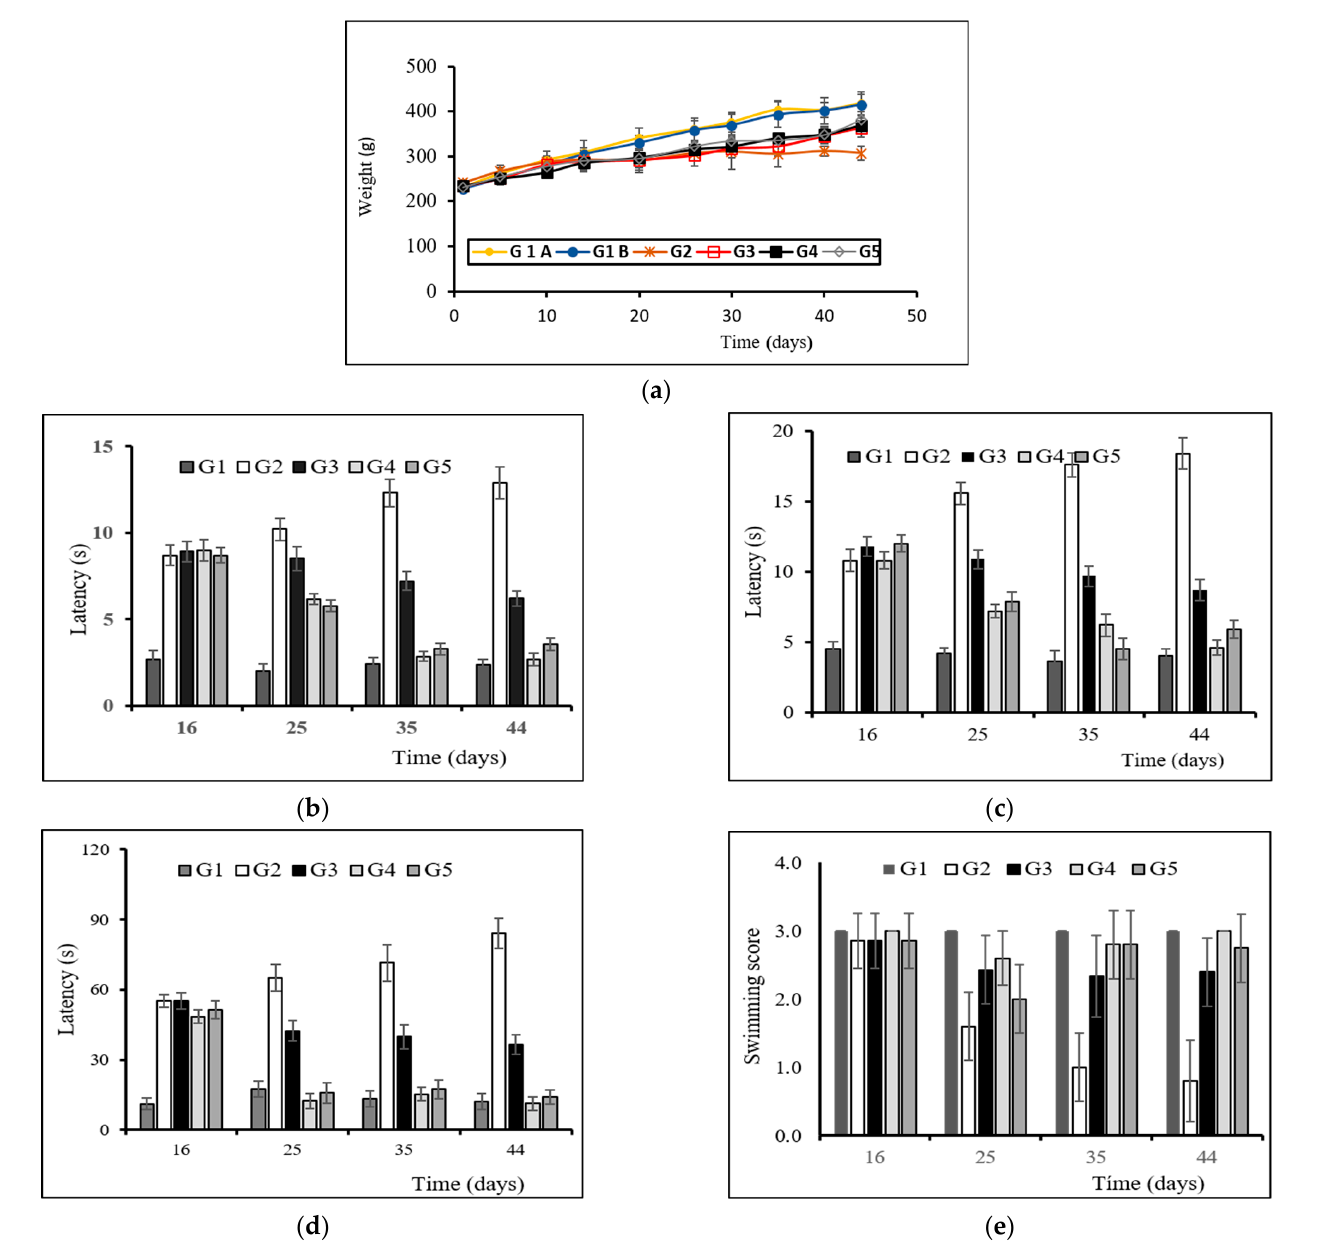
Figure 3. Evolution of rat-body weight throughout the study (44 days) ( a ). Results of the behavioral tests: catalepsy test on bar ( b ) and grid ( c ), akinesia test ( d ), and swim-test ( e ). Animal groups: control subgroups (G1A and G1B); RT-treated control group (G2); RT-treated animals also receiving formulation MP-TC4 (G3), formulation NP-TC3 (G4), and TC in saline (G5). RT (rotenone), TC